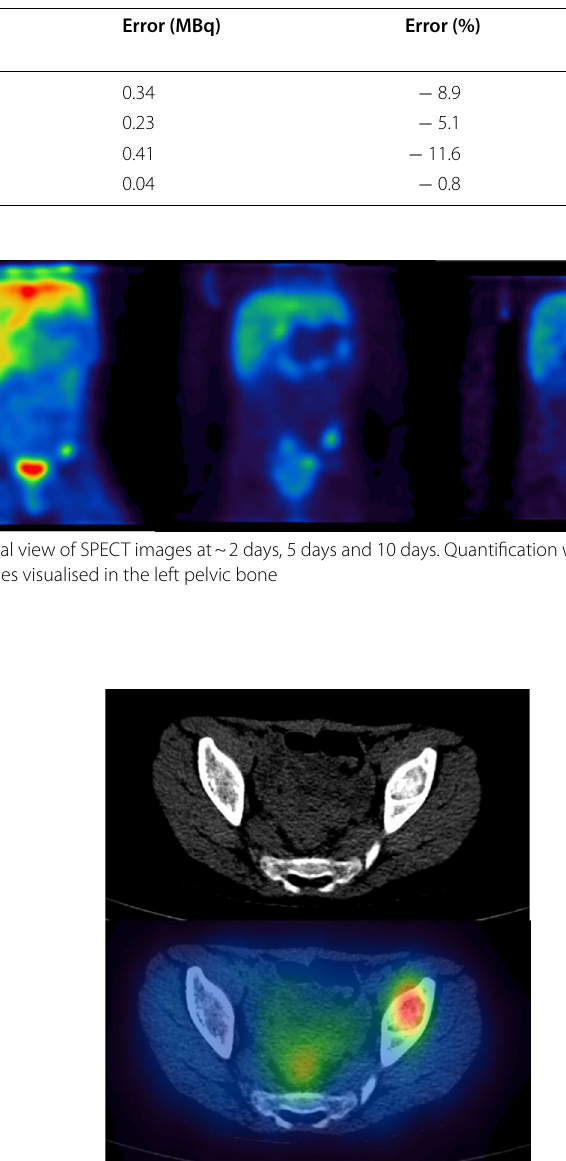
Table 2 Errors and uncertainties in quantification using the proposed method for four lesions in the anthropomorphic phantom